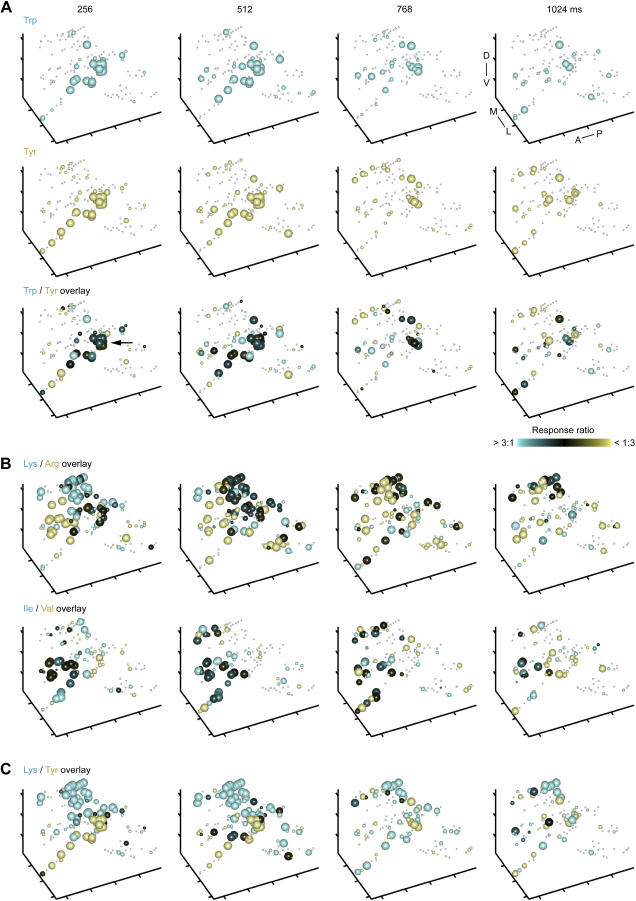
Reduction of Overlap between MC Activity Patterns over Time(A) Top and middle: Three-dimensional MC activity patterns evoked by two related stimuli (Trp and Tyr) in successive 256-ms time bins (same as in Figure 5A; same conventions; n = 131 MCs). Bottom: overlay. The size of spheres represents the magnitude of the larger response to the two stimuli; the color indicates the response ratio. Pure colors (yellow or cyan) indicate that a given MC responded predominantly to one of the two stimuli; black indicates similar responses to both stimuli. Arrow indicates high degree of overlap in focus during the initial phase of the response. Distance between ticks is 50 μm on all axes. Orientation is as indicated: anterior to posterior (A–P), medial to lateral (M–L), and dorsal to ventral (D–V).(B) Further examples of MC response patterns evoked by chemically related stimuli (overlays; same conventions as in [A]).(C) Overlay of MC response patterns evoked by two dissimilar stimuli. Same conventions as in (A).